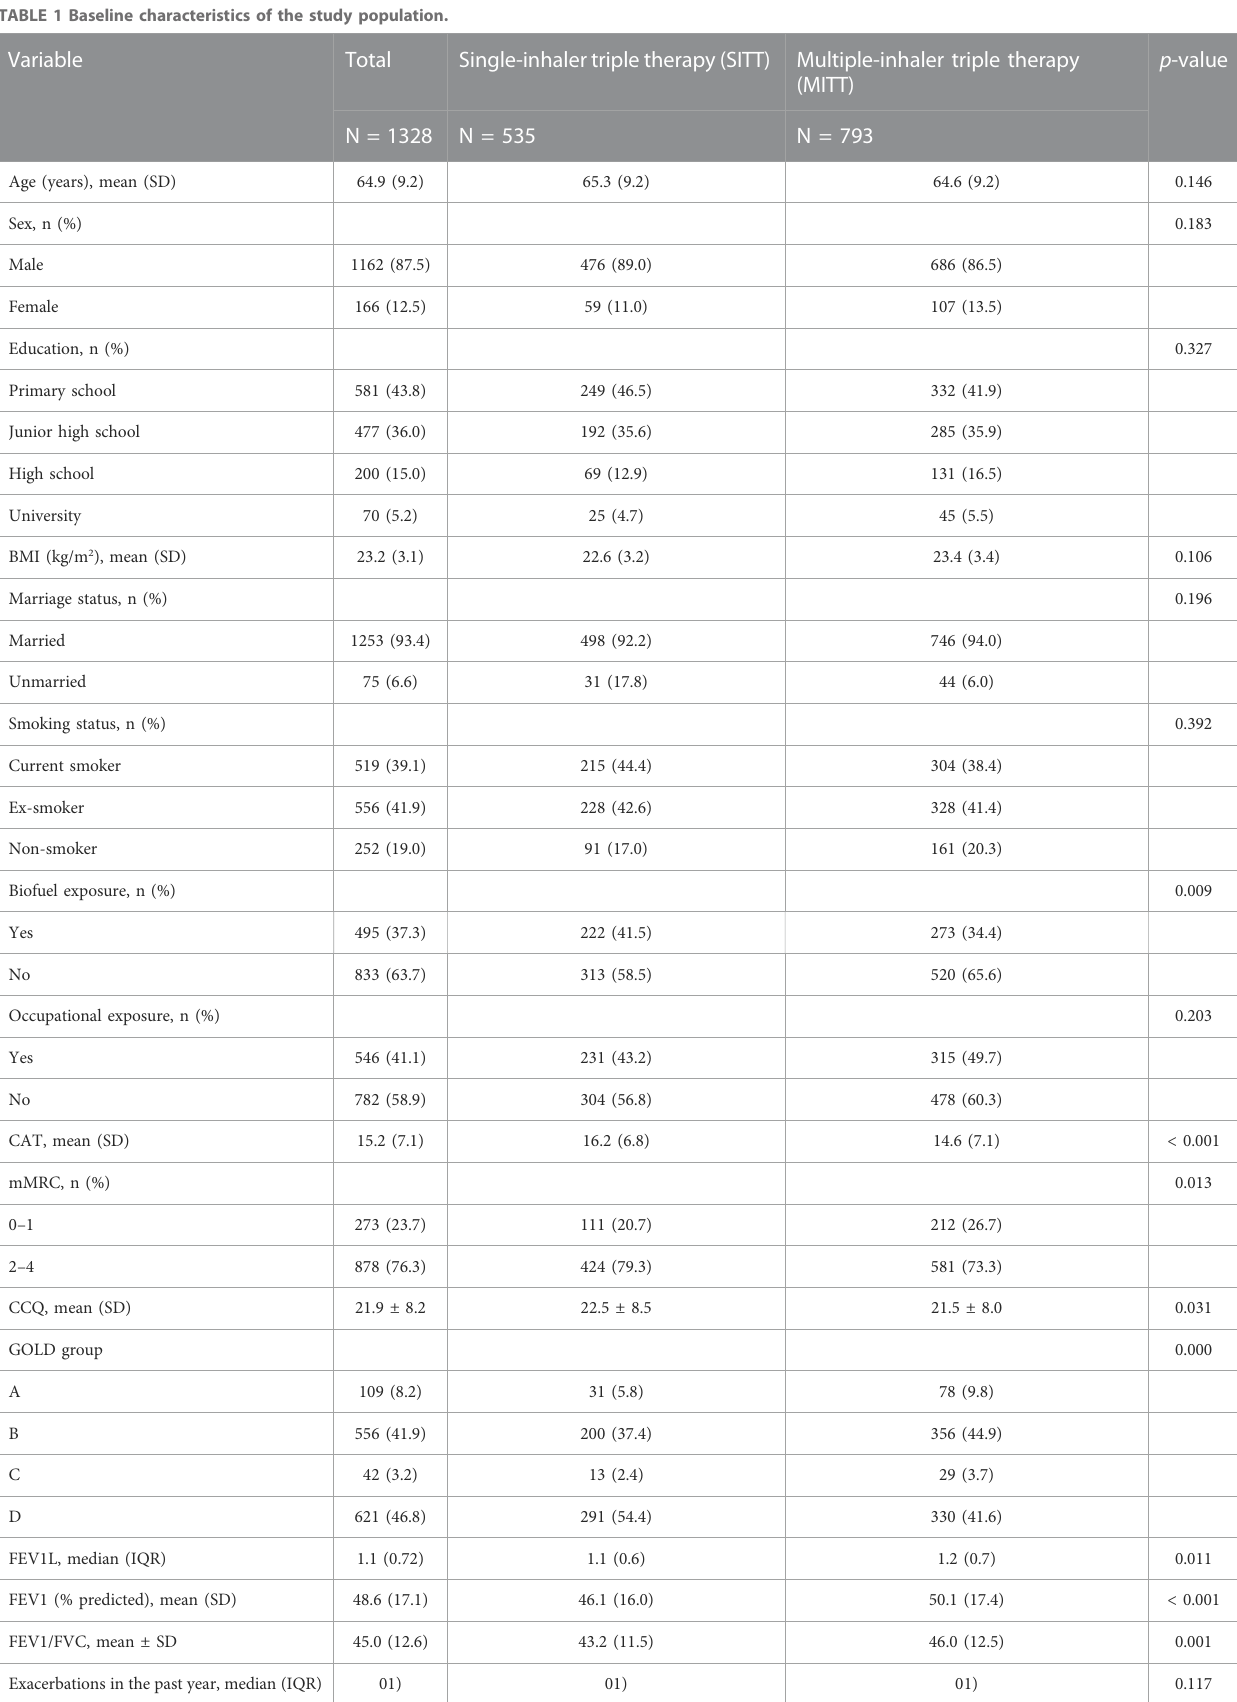
TABLE 1 Baseline characteristics of the study